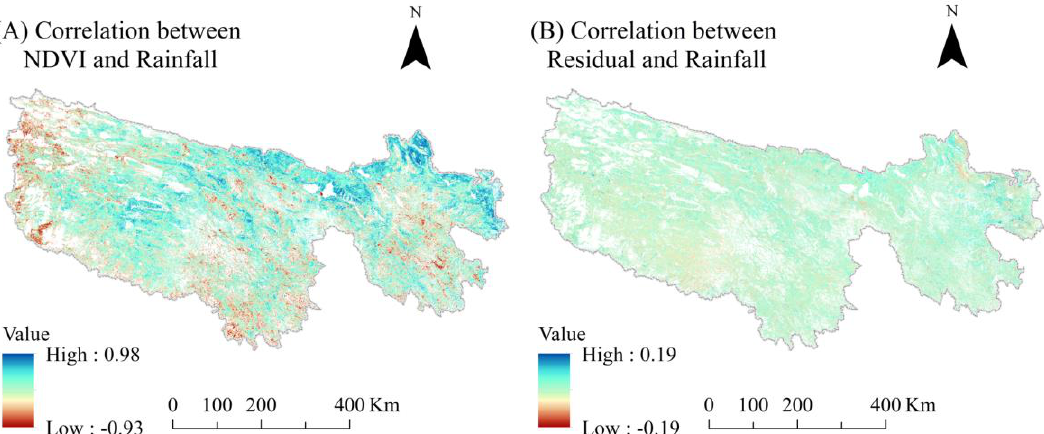
Figure 3. Correlation results based on person correlation analysis. ( A ) Person correlation between NDVI and Rainfall; ( B ) Person correlation between residual NDVI and Rainfall. (spatial reference: Albers conical equal area; datum: D WGS 1984).